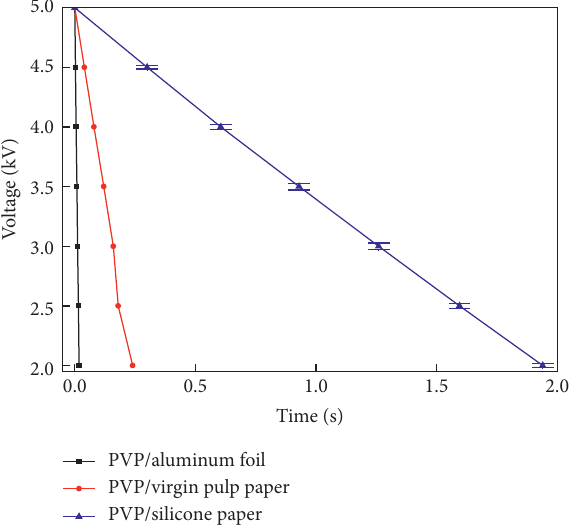
Figure 6: Electrostatic decay of the electrospun fibers on different substrates. Table 2: Comparison of different